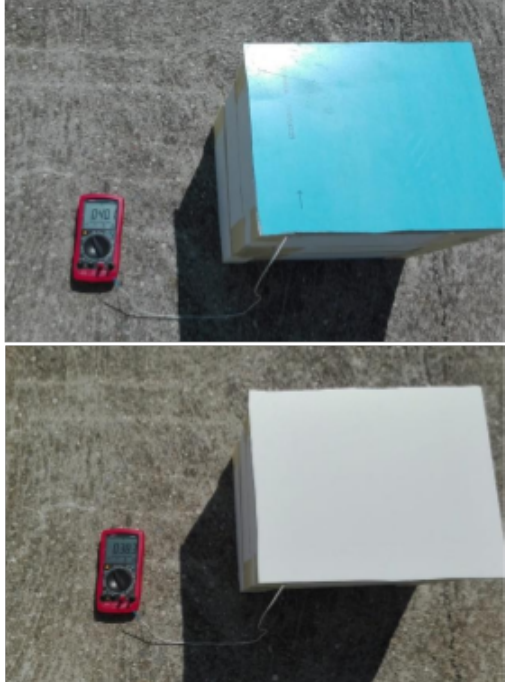
Fig.1 The experiment carried out at CERN Idea Square